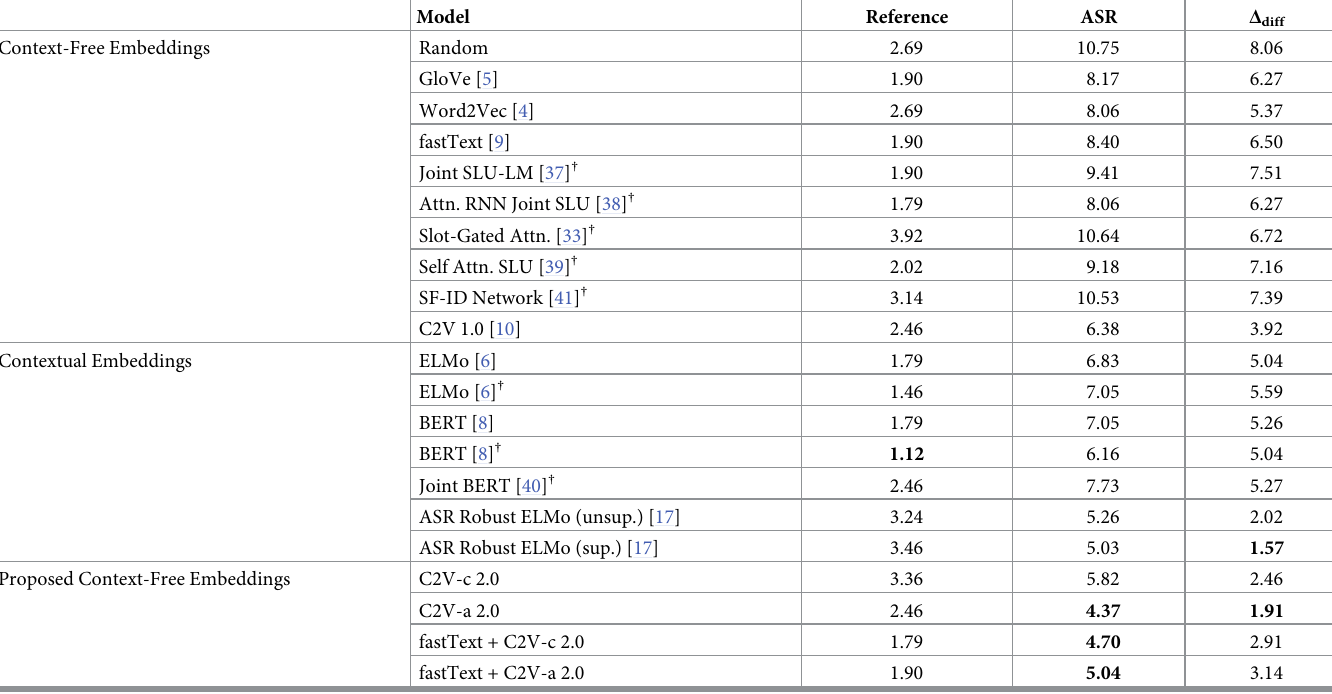
Table 3. Intent Classification Error Rates (CER): Trained on clean reference transcripts, evaluated on clean reference and noisy ASR transcripts.